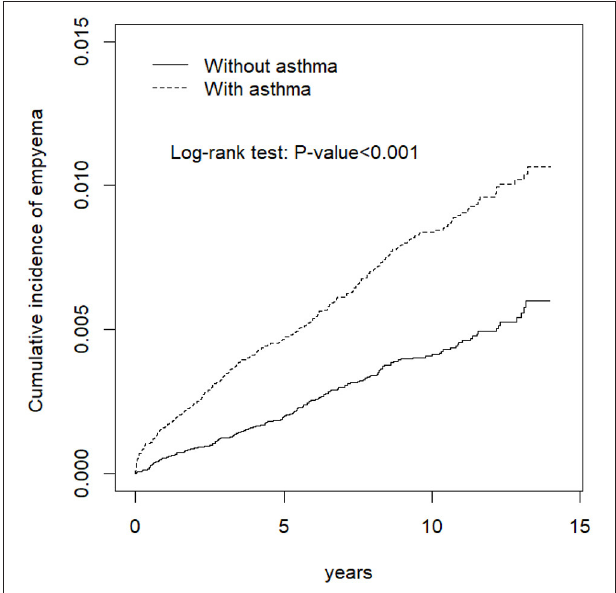
FIGURE 1 | Cumulative incidence of pleural empyema in the asthma group (dashed line) and in the comparison group (solid